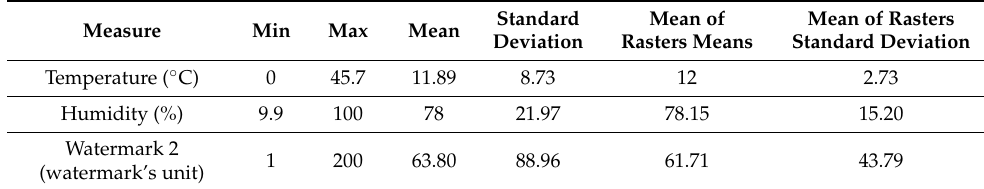
Table 3. Statistical description of the dataset.